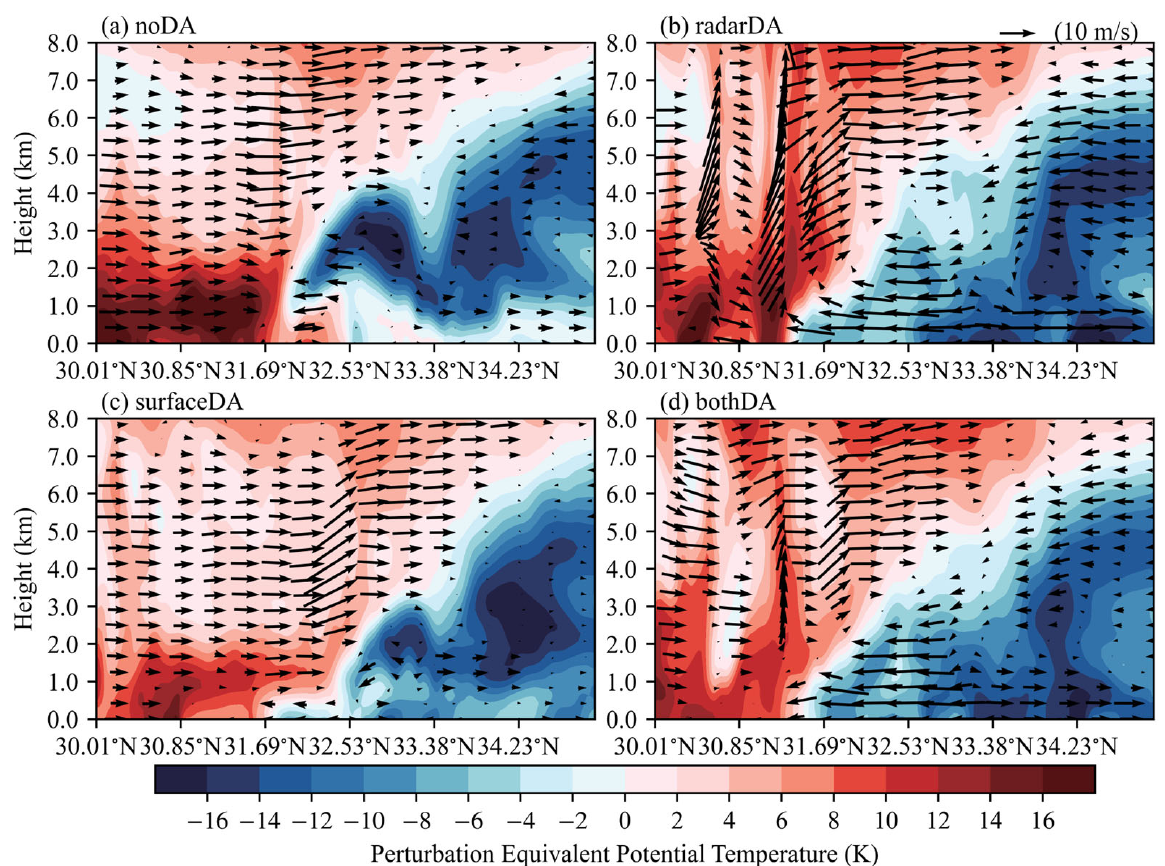
Figure 17. The south–north cross sections of in-plane flow vectors (quiver, units: m · s − 1; vertical motion amplified by a factor of 5) and perturbation equivalent potential temperature (shaded, units: K) along 114.6° E at 1800 UTC 11 July 2014 for ( a ) noDA, ( b ) radarDA, ( c ) surfaceDA and ( d ) bothDA experiments.